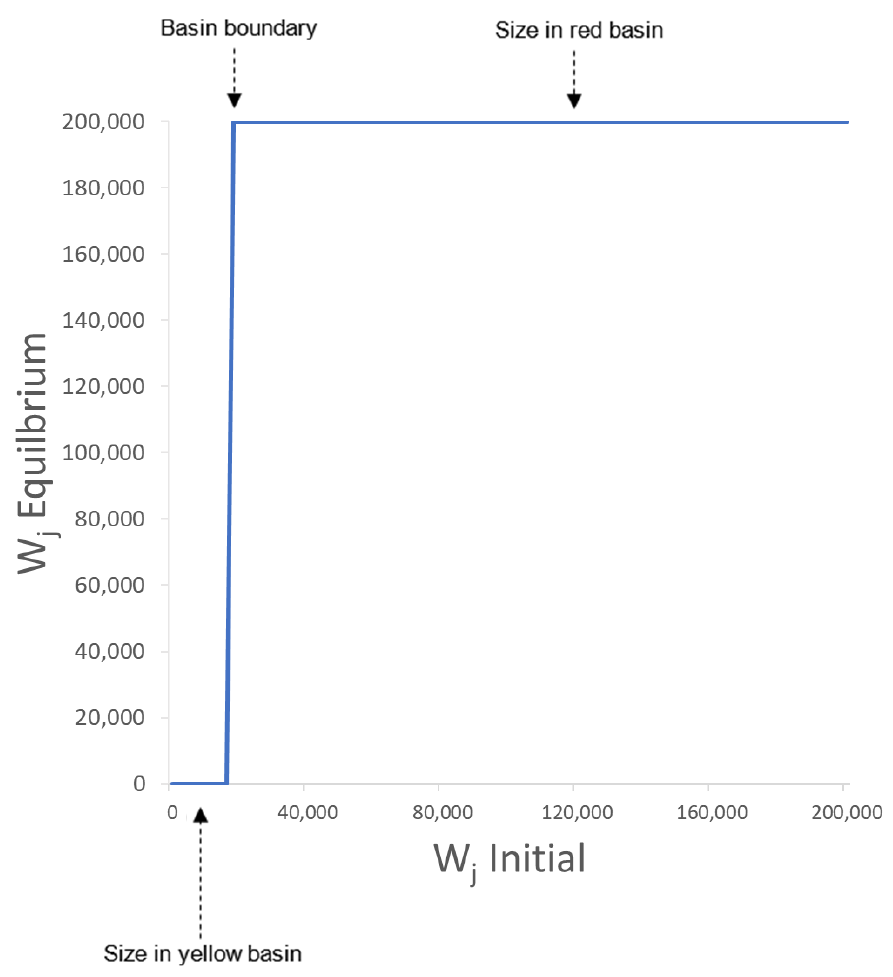
Figure 5. Equilibrium-size graph for retail zone W 2 in region R2—note: uses the same parameter set as Figure 3a.